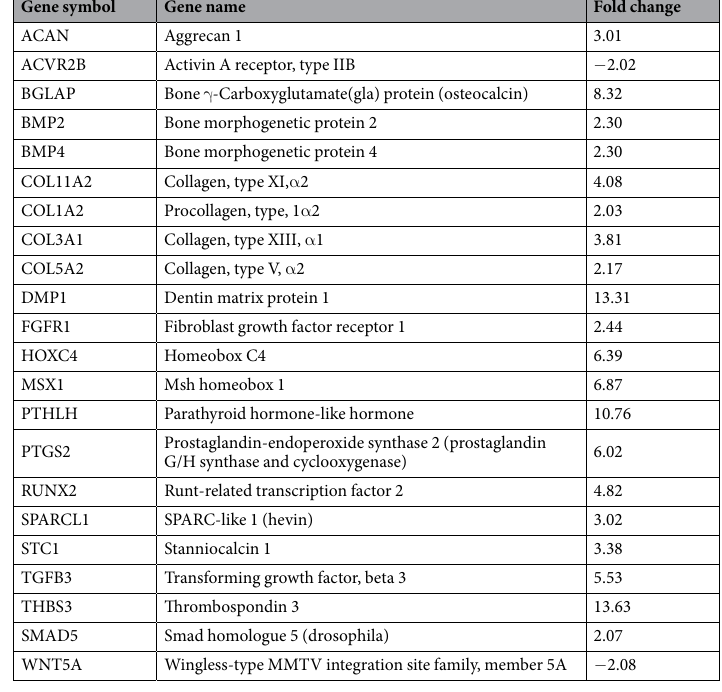
Table 5. Gene members of the “Skeletal development” gene ontology group over-represented in the list of differentially expressed genes between week 1 and 2 (positive value indicates up-regulation at week